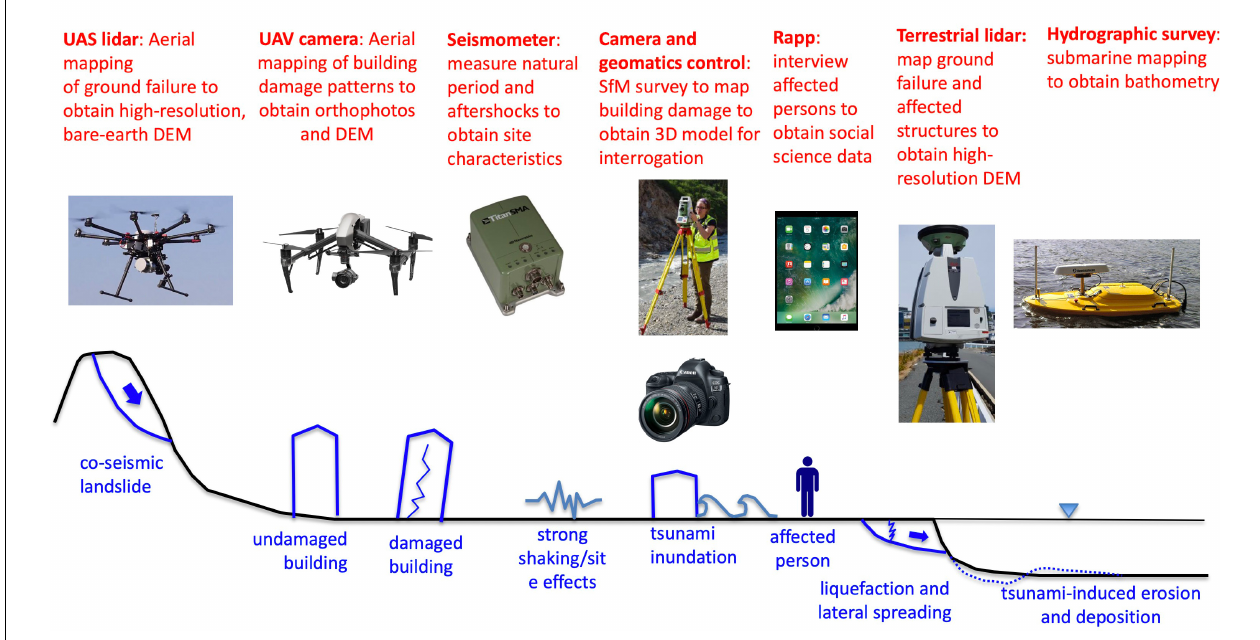
FIGURE 5 | Diagram illustrating damage features, secondary effects, and human and societal impacts that often result from a significant earthquake (blue illustrations and accompanying text). Superimposed above this hypothetical post-event landscape are annotations linking instrumentation (shown with inset photographs) and data collections activities and products (shown in red) to event features.